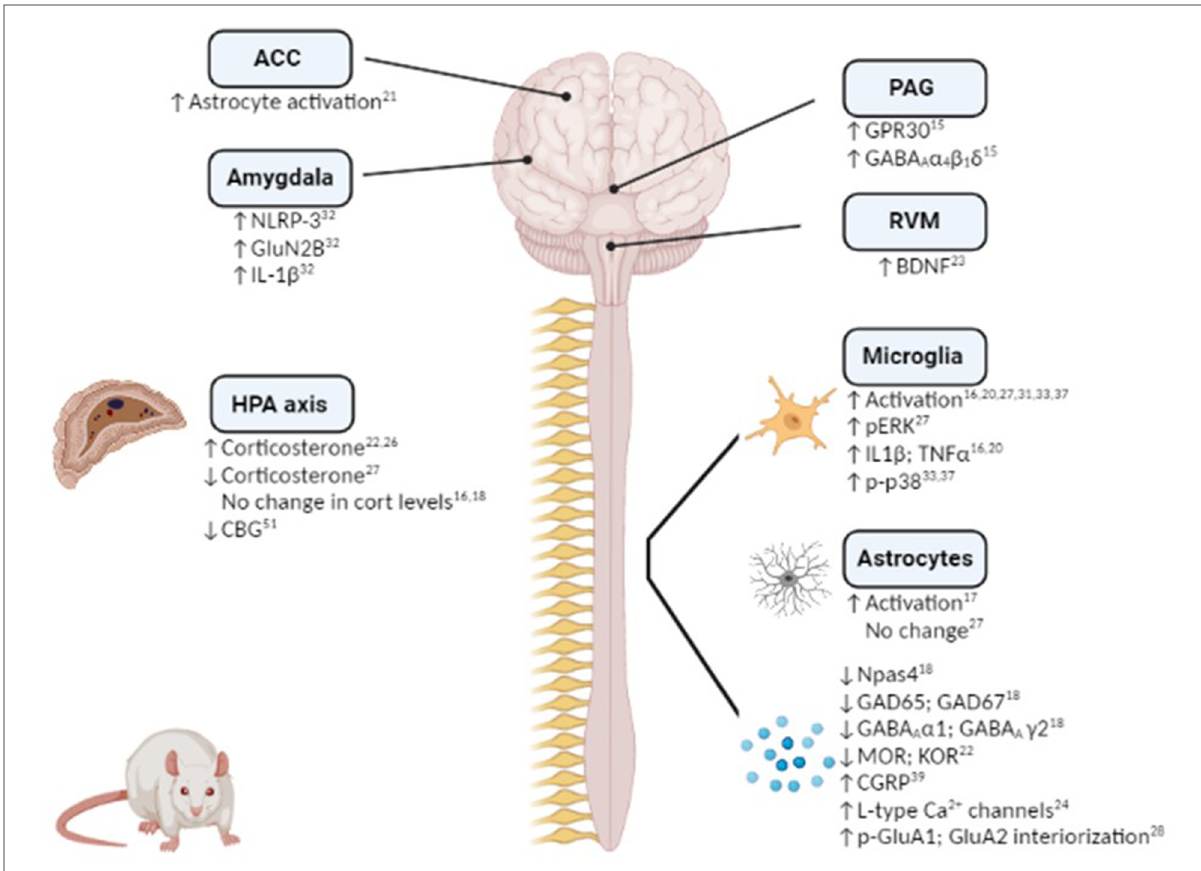
FIGURE 1 Mechanistic changes associated with stress-induced exacerbation and/or prolongation of post-surgical hypersensitivity in preclinical rodent models. Figure created using